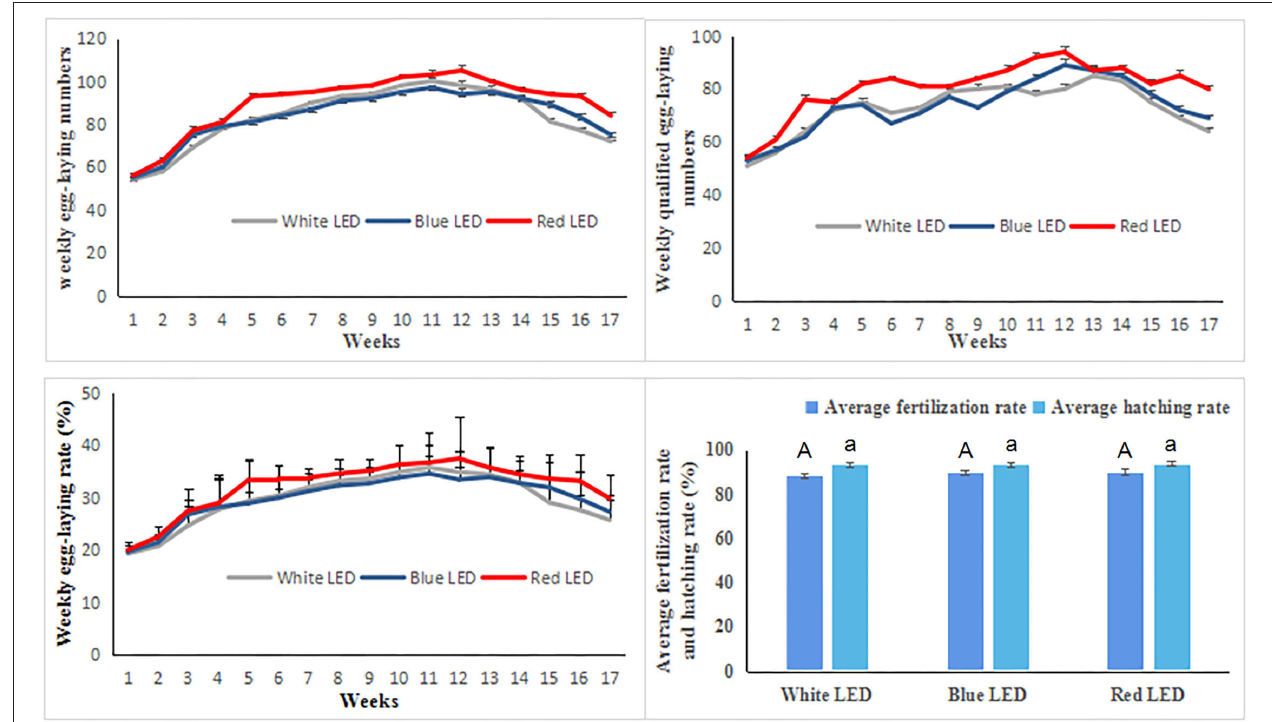
FIGURE 1 | The weekly average egg-laying numbers, qualified egg-laying numbers, egg-laying rate, fertilization rates, and hatching rates of Zi-goose under different color LED treatments. The uppercase letter A indicates the difference significance of average fertilization rate while the lowercase letter a indicates for the difference significance of average hatching rate under different color LED illumination.